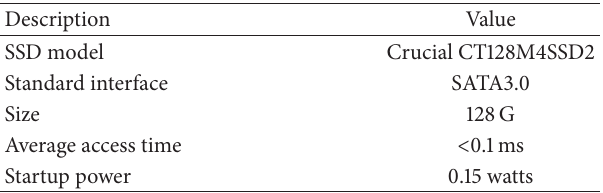
Table 2: The characteristics of the SSD.